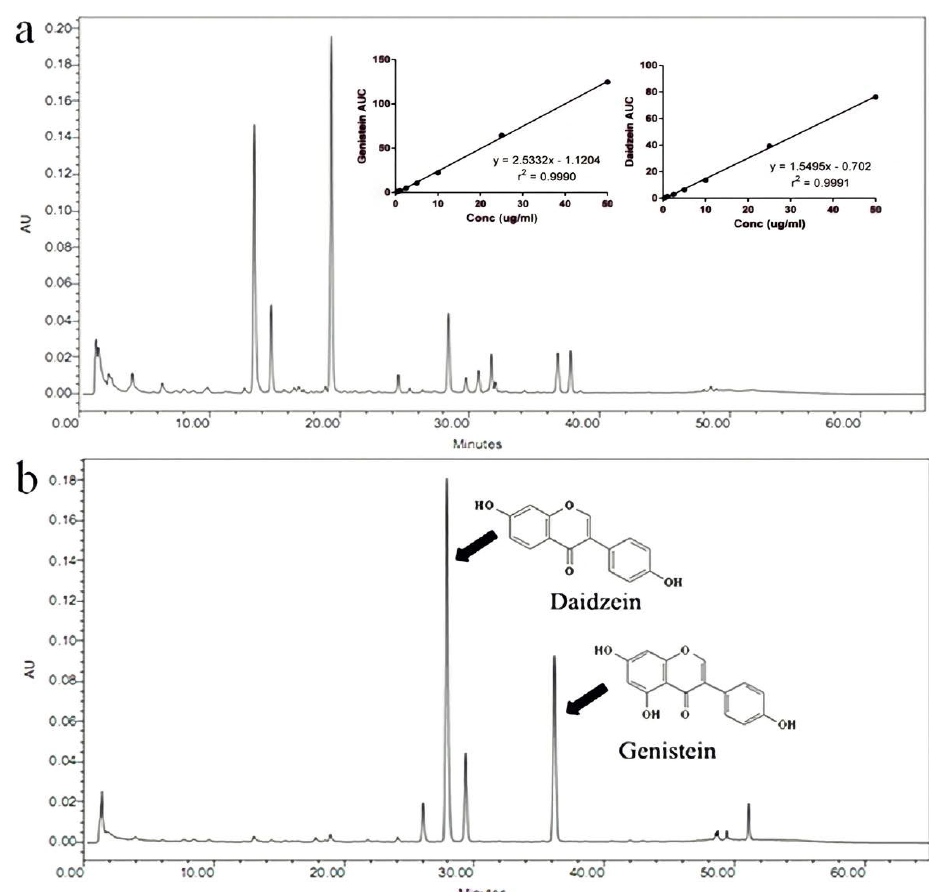
Figure 1. HPLC chromatograms of ( a ) non-fermented soybean extract and ( b ) A . oryzae TISTR 3018-fermented soybean extract (FSE) .